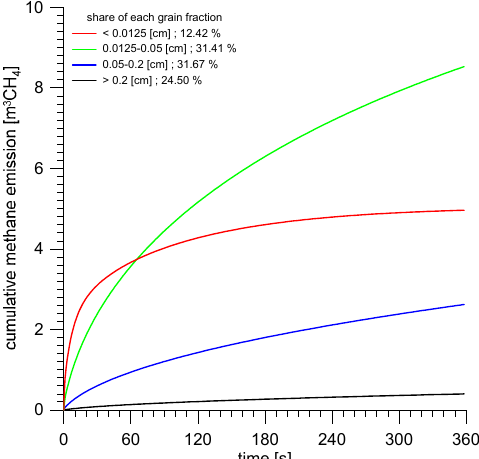
Figure 12. Methane emission in the first 6 s of the outburst from narrowed grain fractions—Zofiówka coal mine. Energies 2019 , 12 , 1999